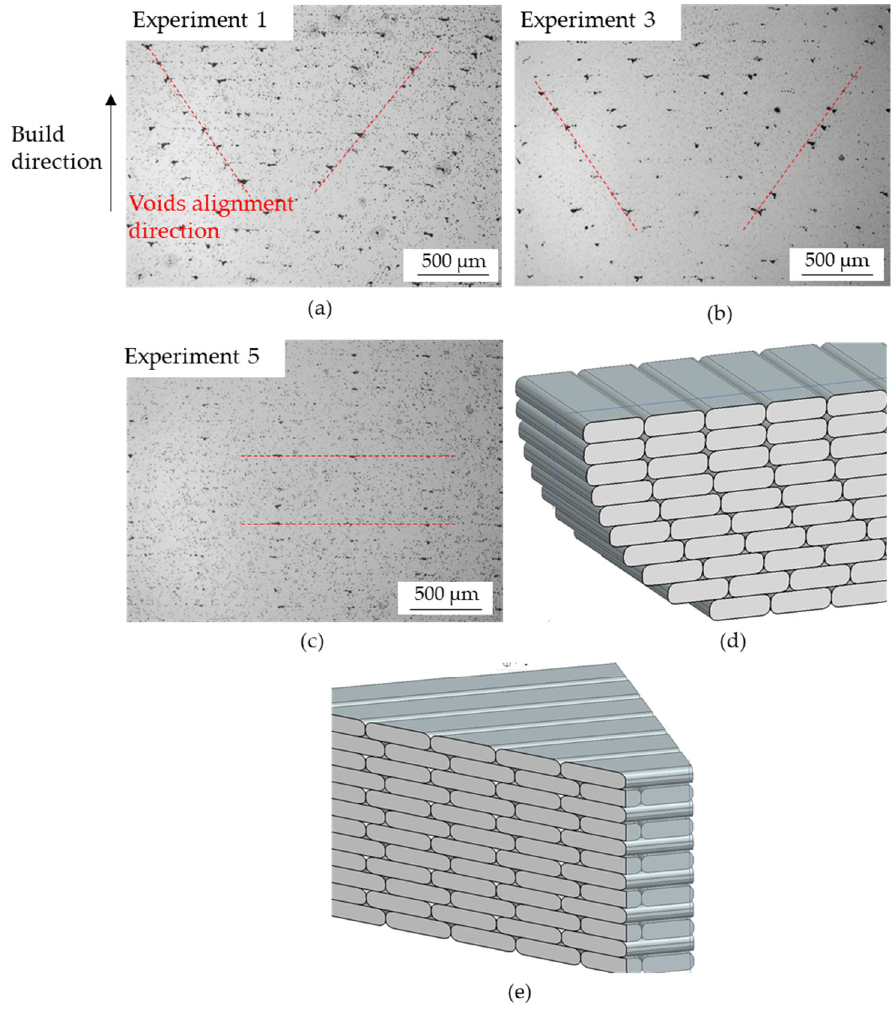
Figure 8. Opto-digital cross-sectional micrographs of ( a ) experiment 1, ( b ) experiment 3, ( c ) experi- ment 5 and raster orientation in ( d ) experiments 1 and 3 and ( e ) experiment